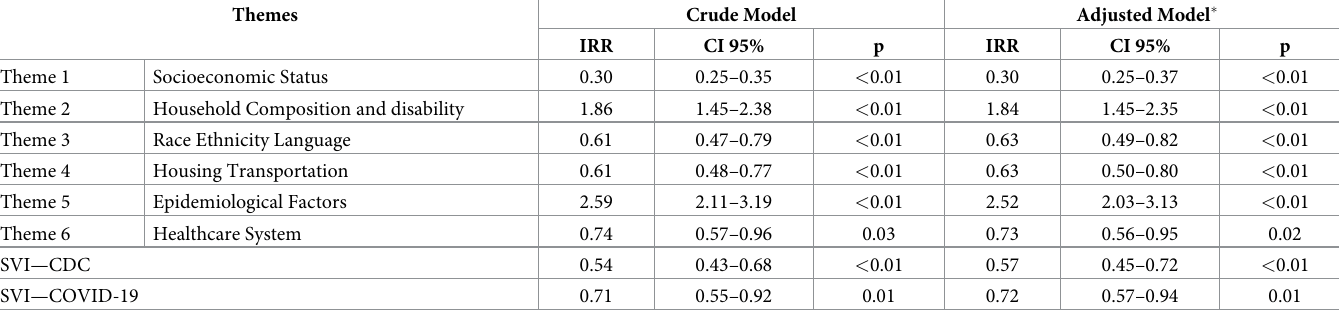
Table 2. Incidence rate ratio of COVID-19 cumulative deaths from March 15, 2020 to September 31, 2021 among Peru’s provinces (N =